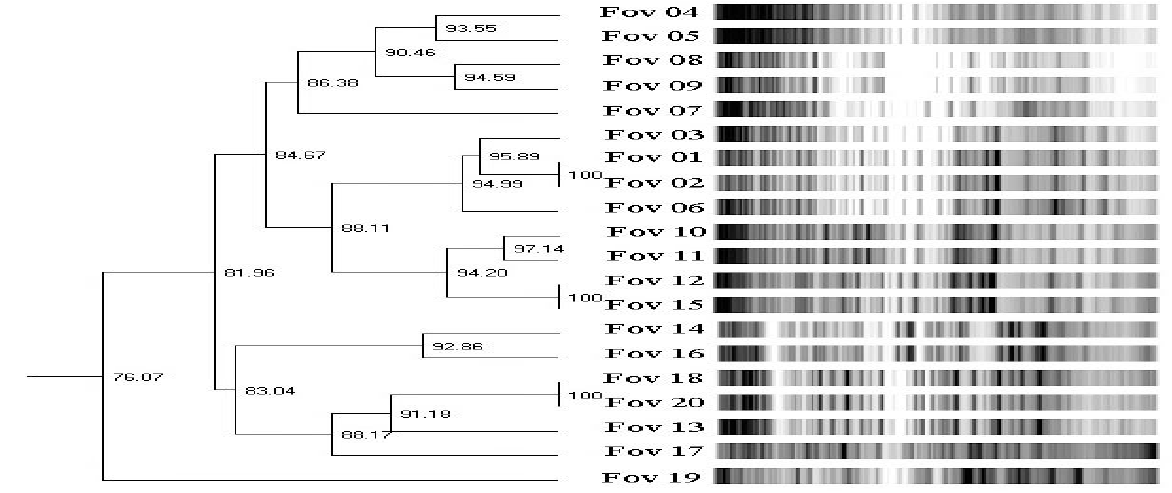
Fig. 2. Digitized AFLP patterns and dendrogram for 20 isolates of Fusarium oxysporum f. sp. vasinfectum using primer combination E-TCC and M-AAA on polyacrylamide gel (4.0%) stained with silver stain. The dendrograms were constructed with the UPGMA clustering method.